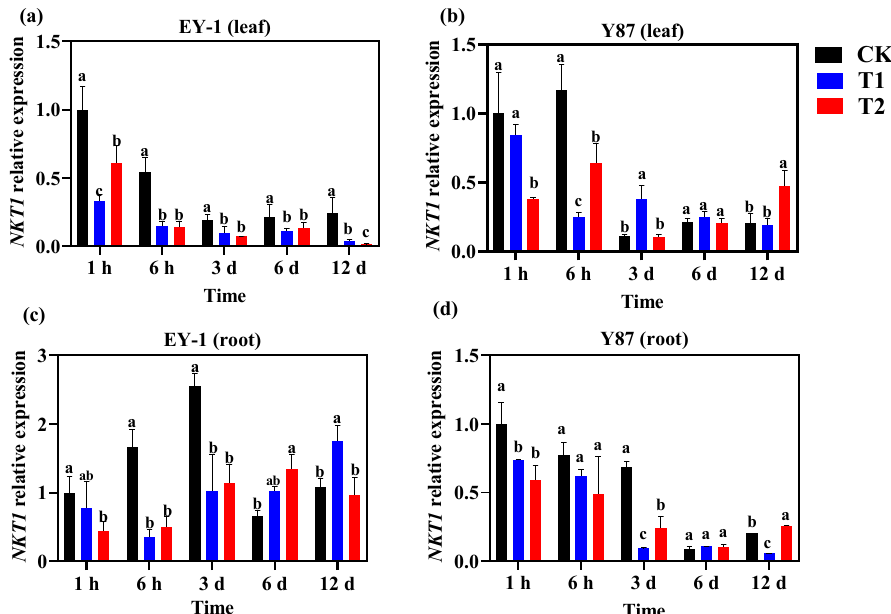
Figure 6. Relative expression levels of the NKT1 gene in EY-1 leaf ( a ), root ( c ) and Y87 leaf ( b ), root ( d ) as determined by real-time PCR. CK: control, T1: topping, T2: IAA application after topping. The mean ± SE of three replicates are shown as error bars. Means with same lowercase letters have no significant difference ( p = 0.05) in the LSD test.